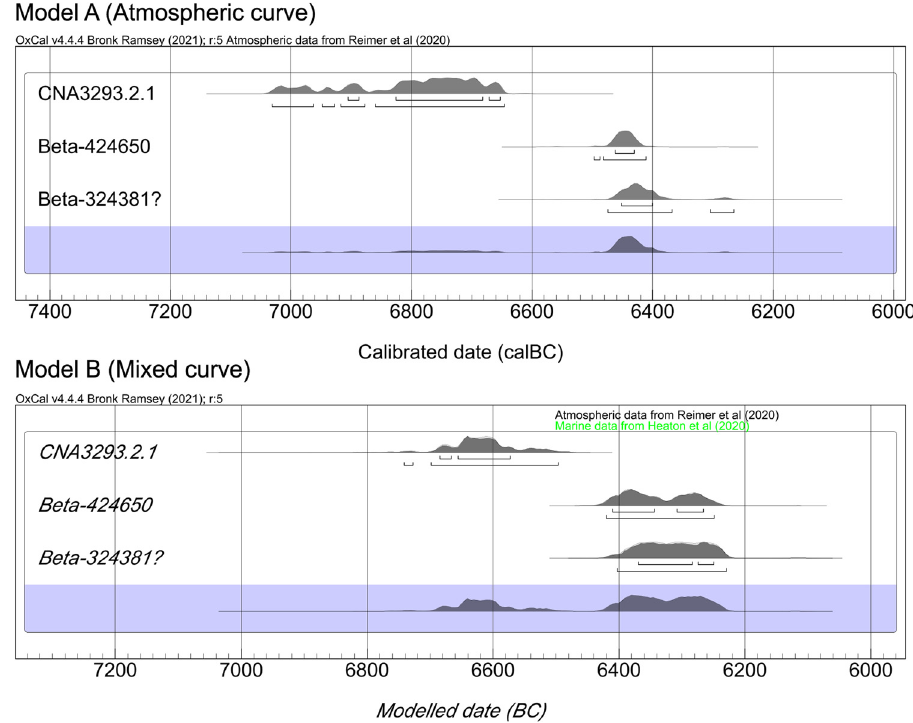
Figure 7: Multi - plots and sums applying the two calibration models. CNA - 3293: Nerja “ Pepita, ” Beta - 424650: Sima Hedionda IV ( 7003 - RM ) , Beta - 324381 ( ? ) ( lab code to be con fi rmed ) : Esqueleto Cave. Model A: atmospheric curve ( Intcal20 ) ( Reimer et al., 2 2020 ) ; Model B: mixed with a 20% of marine curve ( Heaton et al., 2020 ) , including a Δ R value of 94 ± 61. Software used,